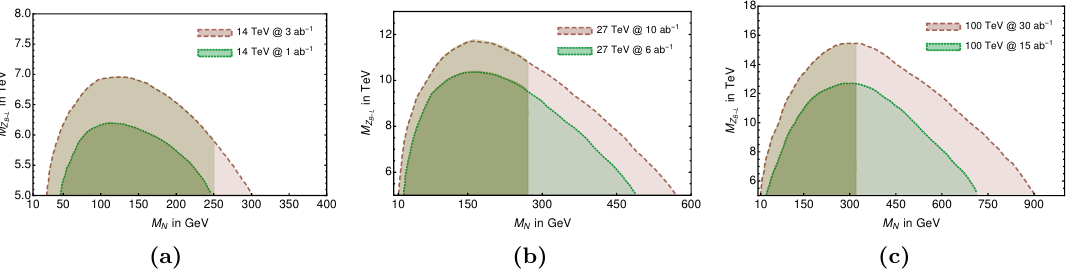
Figure 10. Limits obtained via the inclusive measurements from RHNs decay to displaced 2 ‘ + 2 j final state (dark shaded region), displaced 2 ‘ +4 j final state (light shaded region) and it is presented in M versus M plane at 95% CL. The shaded regions can be probed at any of the detectors Z B − L N CMS, ATLAS and MATHUSLA for 14, 27 TeV centre of mass energies, and at either of the FCC-hh reference detector and MATHUSLA for 100 TeV centre of mass energy, considering the root sum square values of the Yukawa couplings discussed in subsection